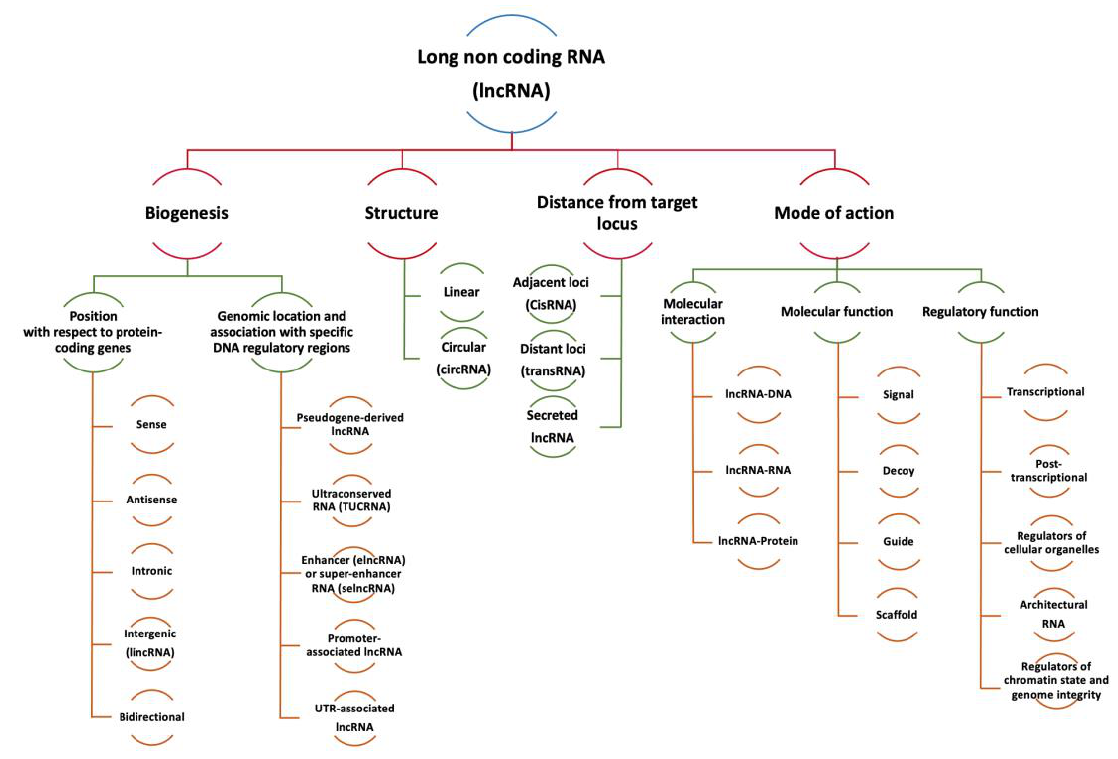
Figure 3. Classification of long non-coding RNAs (lncRNAs) according to biogenesis (where they are transcribed), structure, effects exerted on DNA sequence, and mode of action including molecular interaction, molecular, and regulatory function.